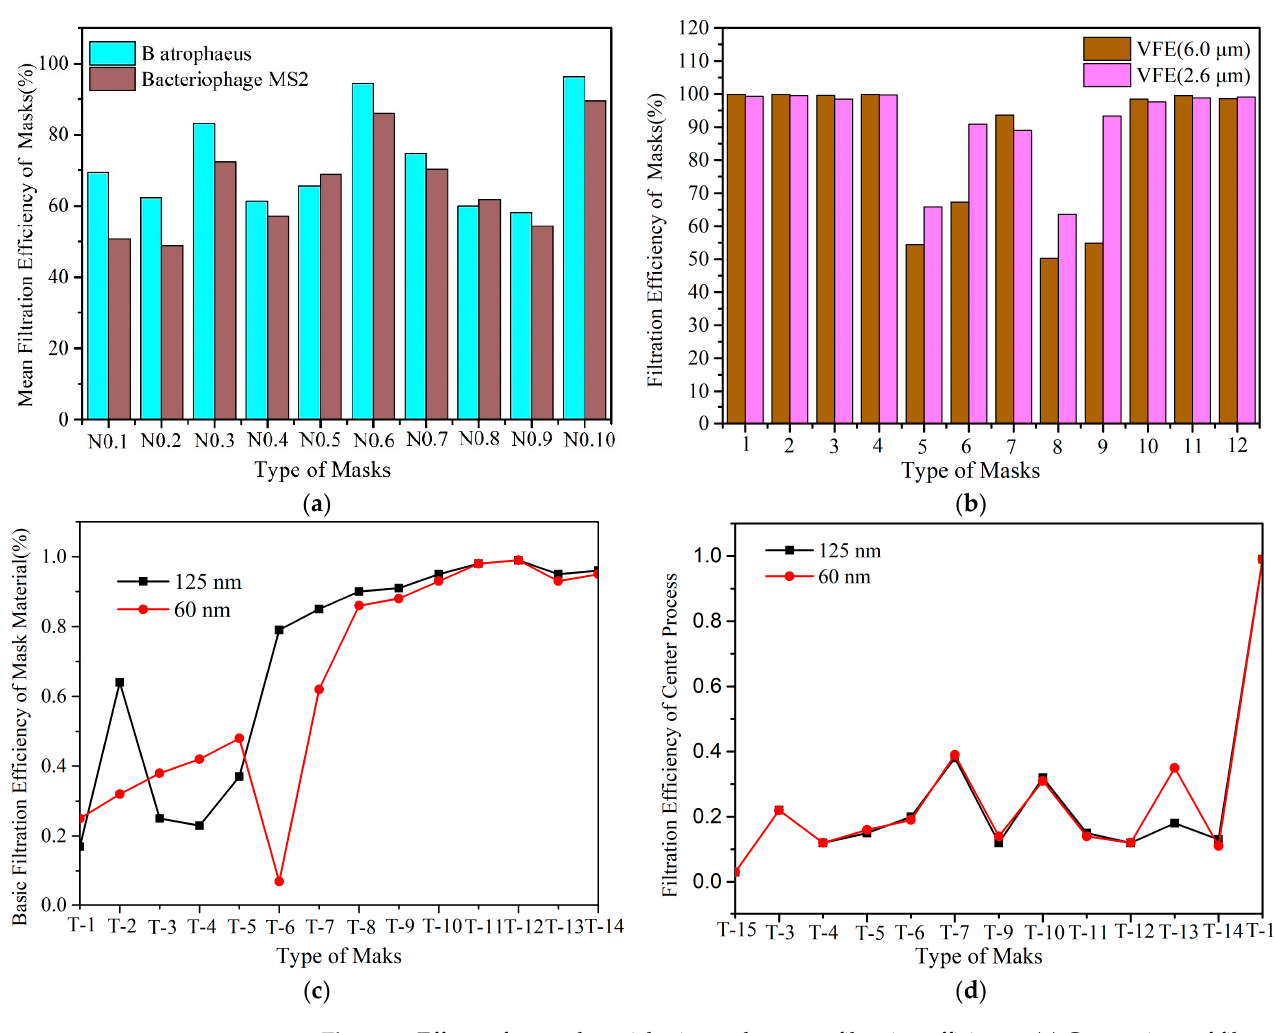
Figure 3. Effects of aerosol particle size and type on filtration efficiency: ( a ) Comparison of filtration efficiency between surgical masks and 9 types of fabric mask. N0.1–N0.10 represent 100% cotton, scarf, tea towel, pillowcase, antimicrobial pillowcase, vacuum cleaner bag, cotton mix, linen, silk, and surgical mask; these categories of masks are derived from those defined in the literature [86]. ( b ) The filtration efficiencies of 6 different types of fabrics were compared for 2 aerosol sizes, 6.0 µ m and 2.6 µ m, respectively. Numbers 1–12 represent the N95, surgical 1, surgical 2, disposable 1, fabric 1, fabric 2, fabric 3, fabric 4, fabric 5, fabric 5+dw, fabric 5+vb, and fabric 6; the categories of masks are derived from those defined in the literature [101]. ( c ) Basic filtration efficiency of mask material [87]. ( d ) The filtration efficiency with insertion of a layer into a 2-layer cotton mask. T-1–T-16 represents cotton 1 layer, dust mask, #4 coffee filter, cotton 1 layer, shop towel, filtrate 1500, surgical warp, N95 1 layer, medical mask, shop vac, KN95, N95 2 layers, 3M-8511, FTR467 ULPA, dusk mask,